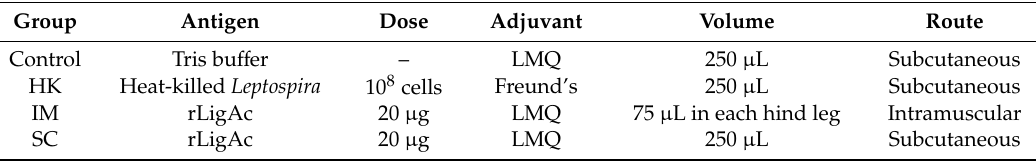
Table 1. Experimental design and vaccine